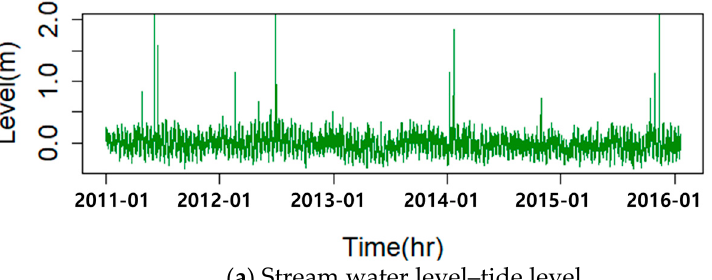
Figure 7. Wave component at Ulsan station.